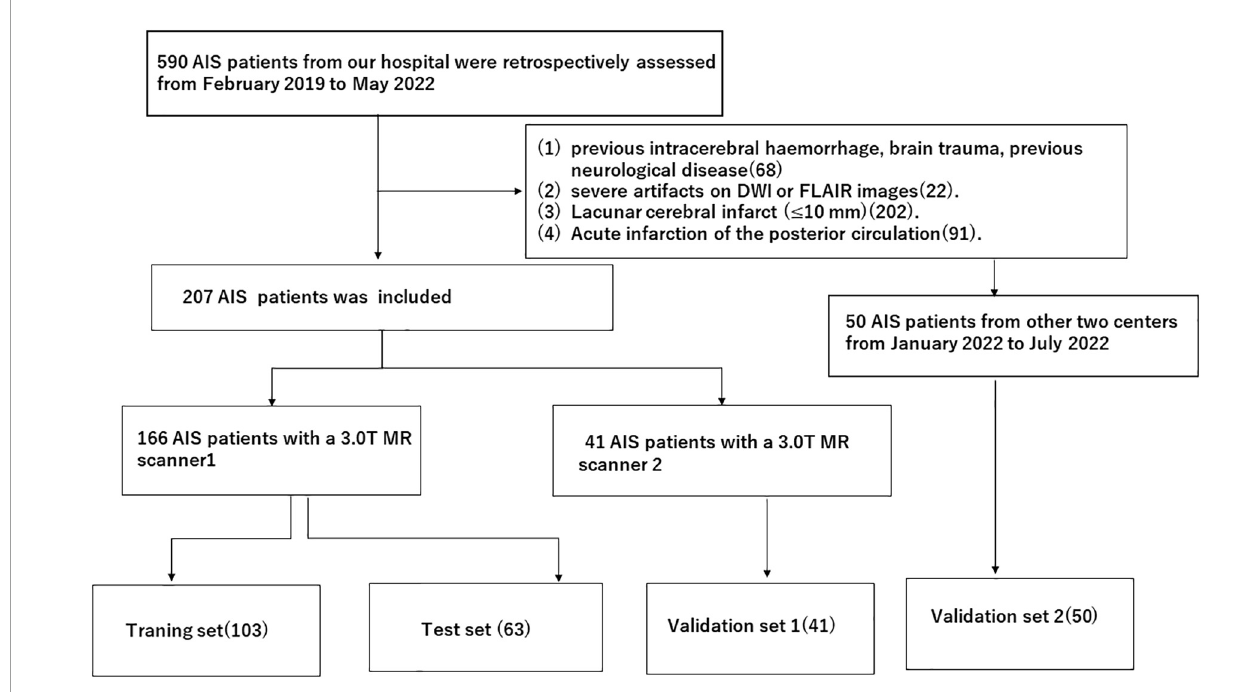
FIGURE1 Distribution diagram of enrolled subjects in training set, test set and external validation sets.